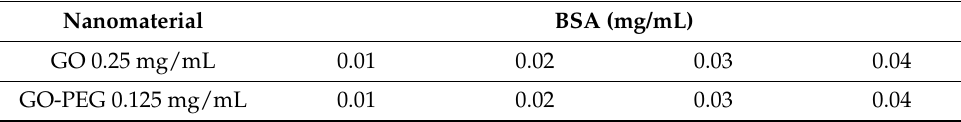
Table 1. Concentrations of the dispersions